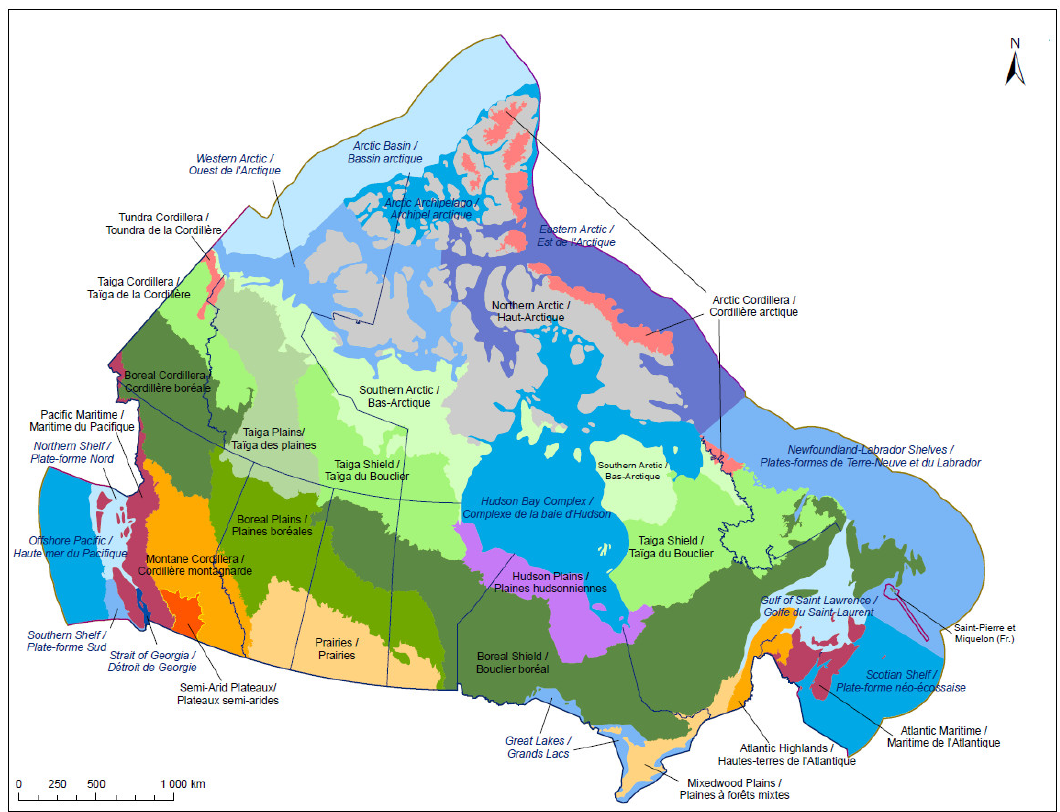
Figure 1. Ecoregions of Canada (Adapted from the Canadian Council on Ecological Areas (CCEA), Figure1. [147] )